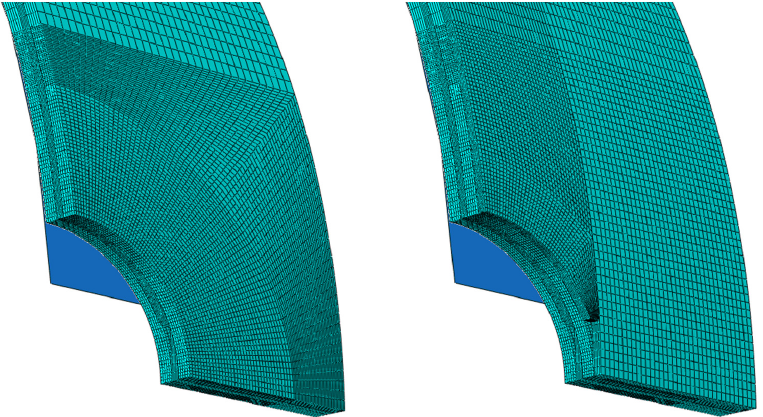
Figure 14. Detail of mesh in split disk model. To the left is from the middle axial layer, to the right is from the upper hoop layer.